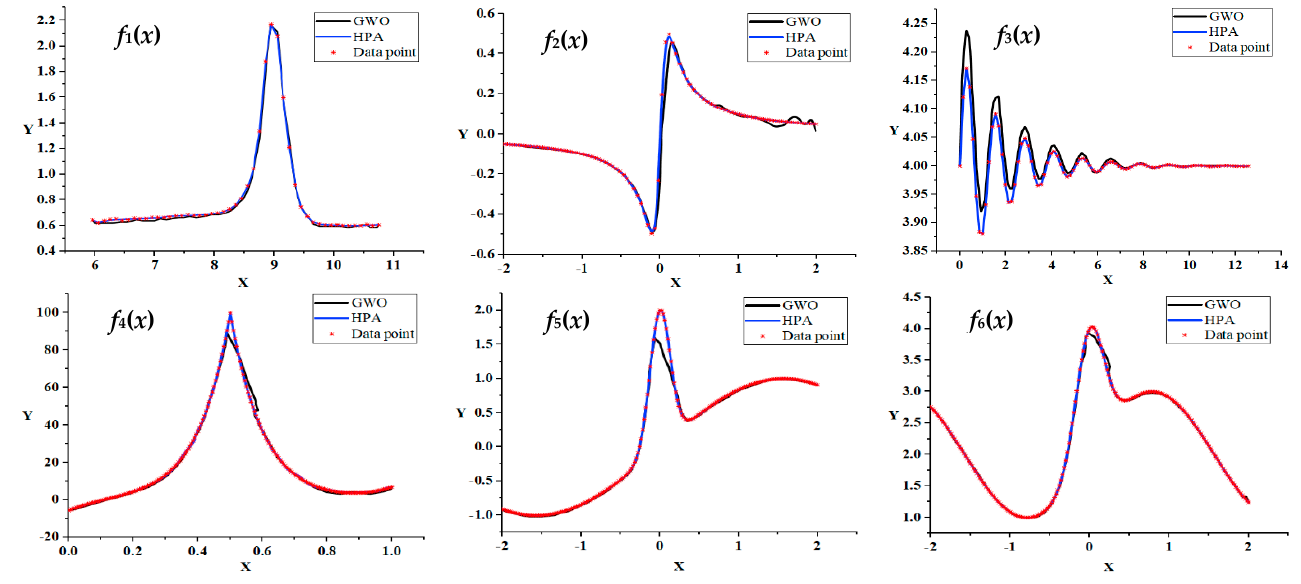
Figure 14. Comparison of GWO and HPA fitting results for six test models. Table 3. The experimental results for all functions.